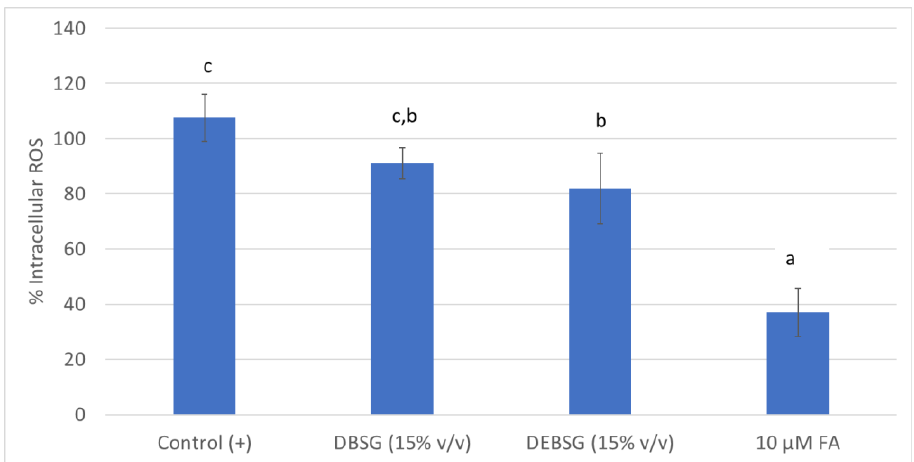
Figure 1. Intracellular ROS formation under physiological conditions in IEC-6 for untreated cells (Control (+)), cells treated with DBSG, cells treated with DEBSG and an antioxidant standard (FA). Percentage of ROS formation was calculated with respect to the Control (+). Different letters within columns show significant differences ( p < 0.05). DBSG: brewers’ spent grain intestinal digest; DEBSG: extruded brewers’ spent grain intestinal digest; FA: ferulic acid.